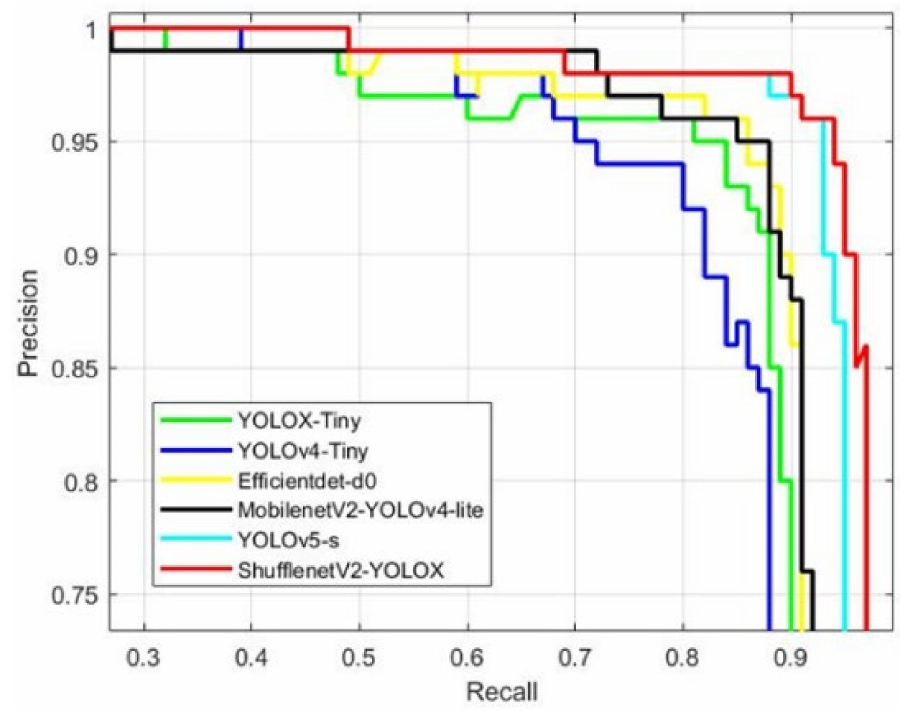
Figure 10. PR curve comparison of ShufflenetV2-YOLOX with other advanced